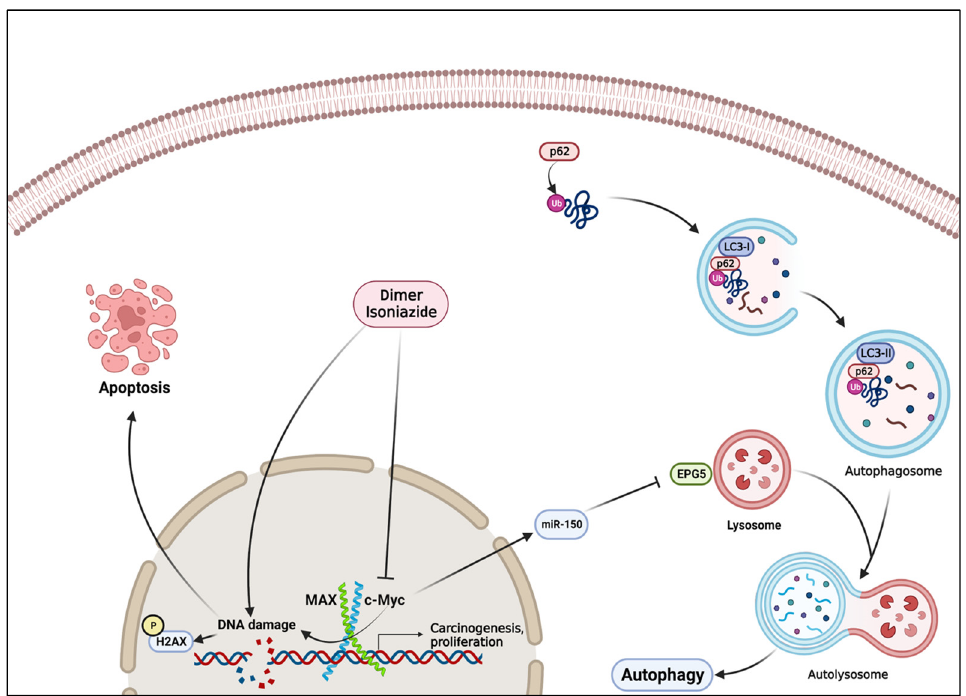
Figure 10. The molecular mechanism of the artemisinin dimer isoniazide. c-MYC inhibits autophagy via miR-150 and EPG axis; therefore, the inhibition of c-MYC by dimer isoniazide led to the induction of autophagy. On the other hand, dimer isoniazide may directly or indirectly—via c-MYC inhibition—cause DNA damage which, in turn, triggers apoptosis. Figure created with BioRender.com.